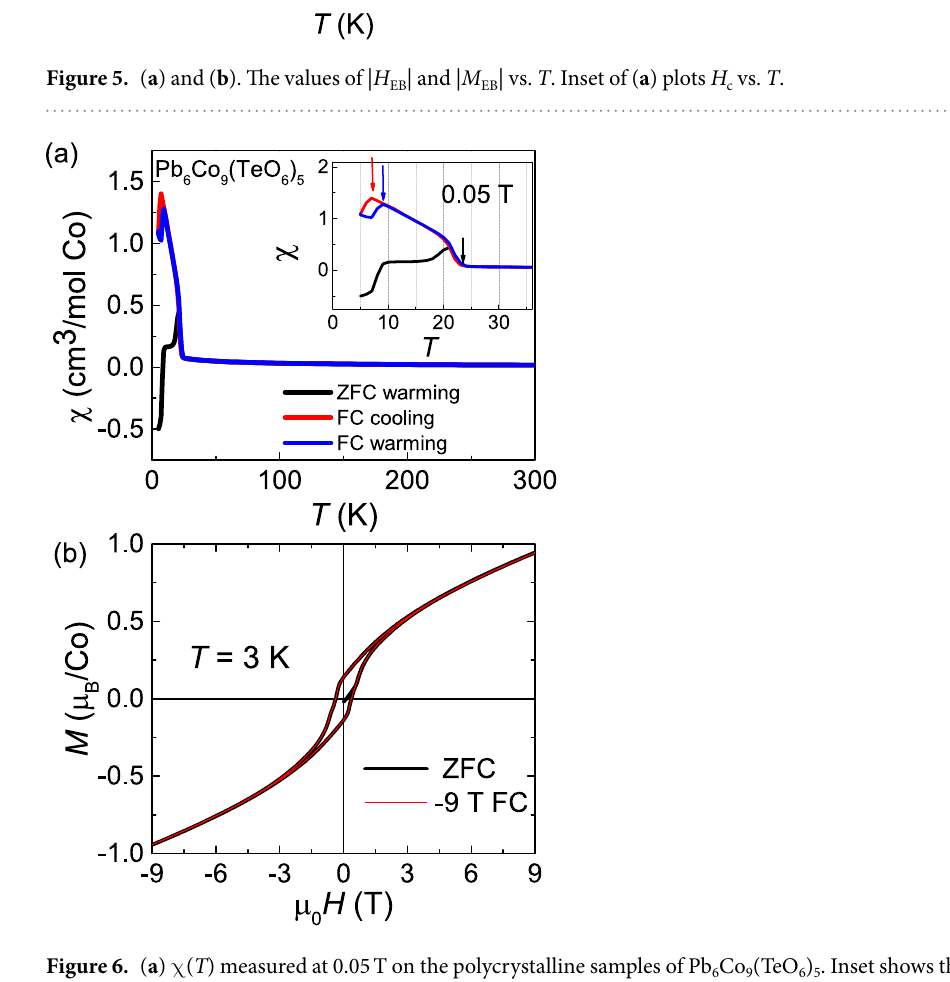
The unusual, large EB behavior in the compound Pb 6 Ni 9 (TeO 6 ) 5 can be understood as follows. The conven- tional exchange bias (CEB) usually appears due to the coupling of two sub-lattices or phases when the system is cooled under magnetic field. During this process, the pinning occurs at the interface and causes the unidirectional